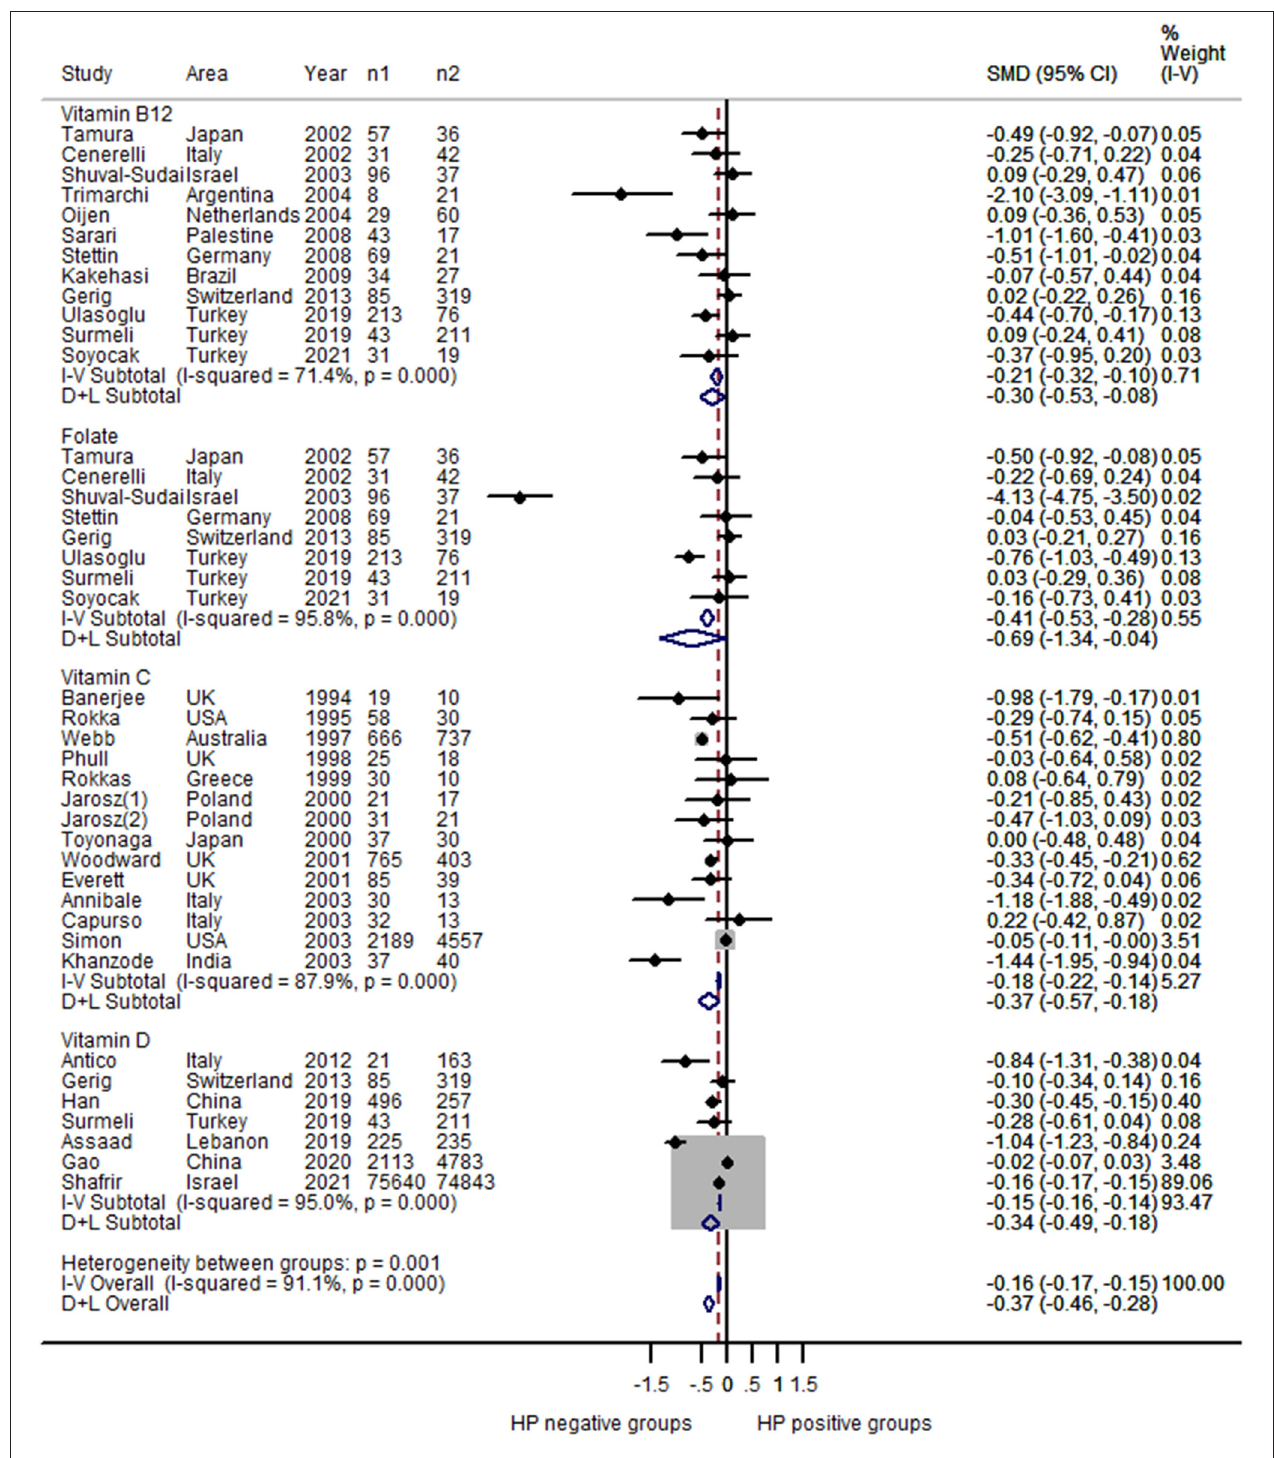
FIGURE 2 | Forest plot of the meta-analysis on comparison of serum vitamin levels between H. pylori - positive and H. pylori - negative patients (n1: number of H. pylori – positive patients; n2: number of H. pylori – negative patients); H. pylori – positive patients had lower serum vitamin B12 levels than H. pylori – negative patients (SMD = –0.30; 95% CI: − 0.53 – − 0.08; P < 0.001; I 2 = 71.4%); H. pylori – positive patients had lower serum folate levels than H. pylori - negative patients (SMD = − 0.69; 95% CI: − 1.34 – − 0.04; P < 0.001; I 2 = 95.8%); H. pylori – positive patients had lower serum vitamin C levels than H. pylori - negative patients (SMD = − 0.37; 95% CI: − 0.57 – − 0.18; P < 0.001; I 2 = 87.9%); H. pylori – positive patients had lower serum vitamin D levels than H. pylori - negative patients (SMD = − 0.34; 95% CI: − 0.49 – − 0.18; P < 0.001; I 2 = 95.0%).